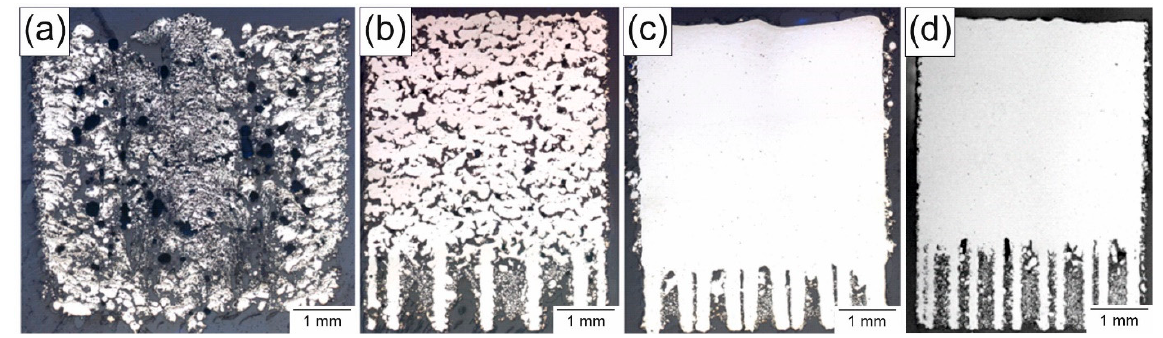
Figure 2. Cross-sections of representative specimens from the process screening ( a – c ) with the parameters shown in Table 2; best overall result of this process development based on the final empirical process model ( d ). Table 2. Set of parameters used for processing of the specimens shown in Figure 2.